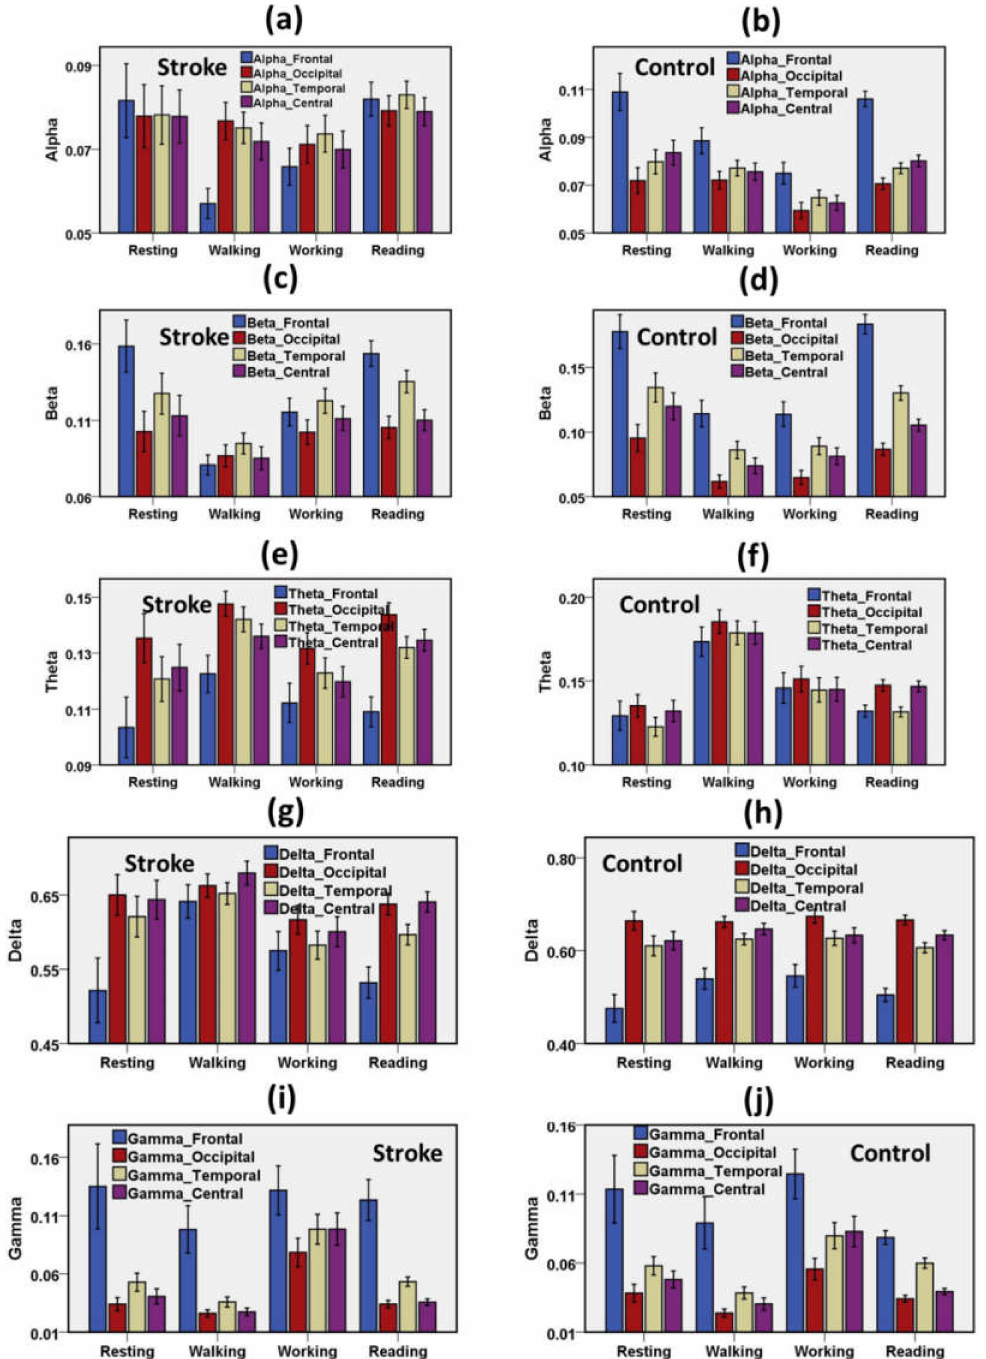
Figure 4. Distribution of spectral waves on the cortical regions (frontal lobe, central lobe, temporal lobe, occipital lobe) during resting, motor, and cognitive tasks. ( a ) RP Alpha of stroke group ( b ) RP Alpha of the control group, ( c ) RP Beta of stroke group ( d ) RP Beta of the control group, ( e ) RP Theta of stroke group ( f ) RP Theta of the control group, ( g ) RP Delta of stroke group ( h ) RP Delta of the control group, ( i ) RP Gamma of stroke group ( j ) RP Gamma of the control group. Error bar shows 95% confidence interval. RP = Relative